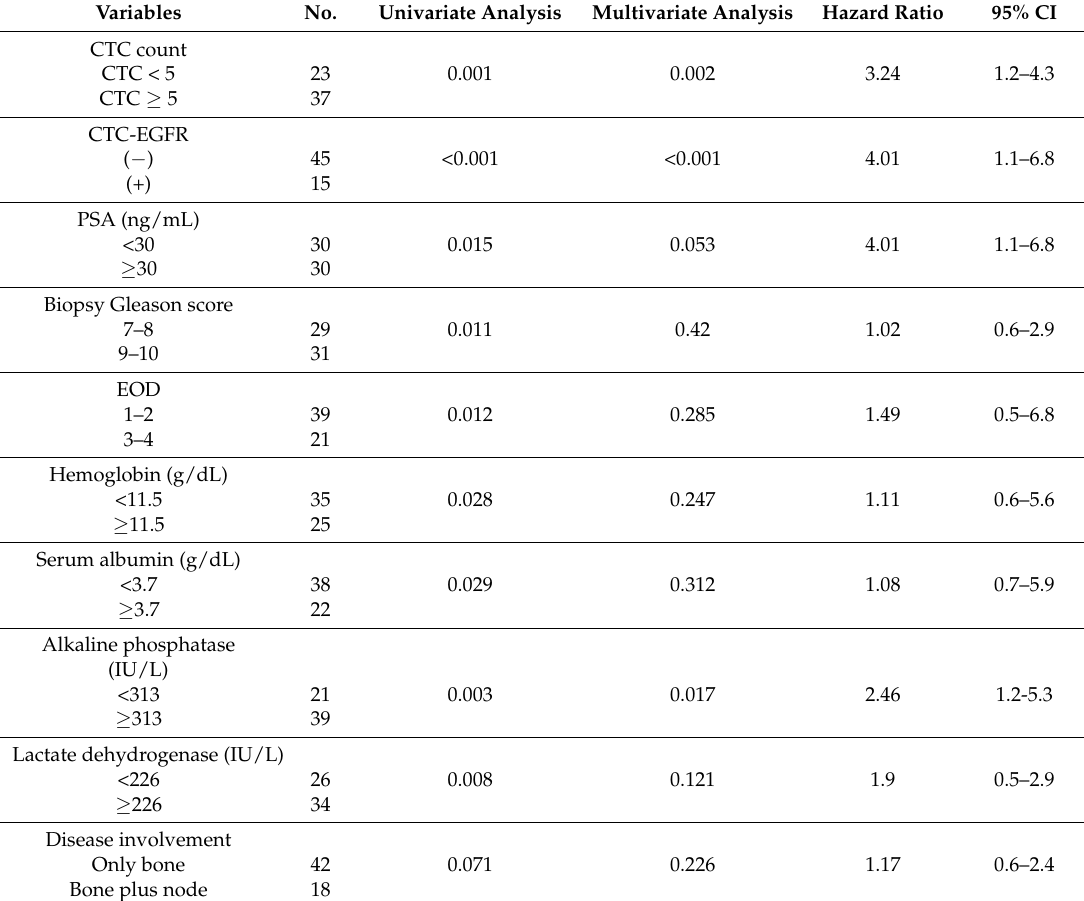
Table 2. Baseline prognosis factors for overall